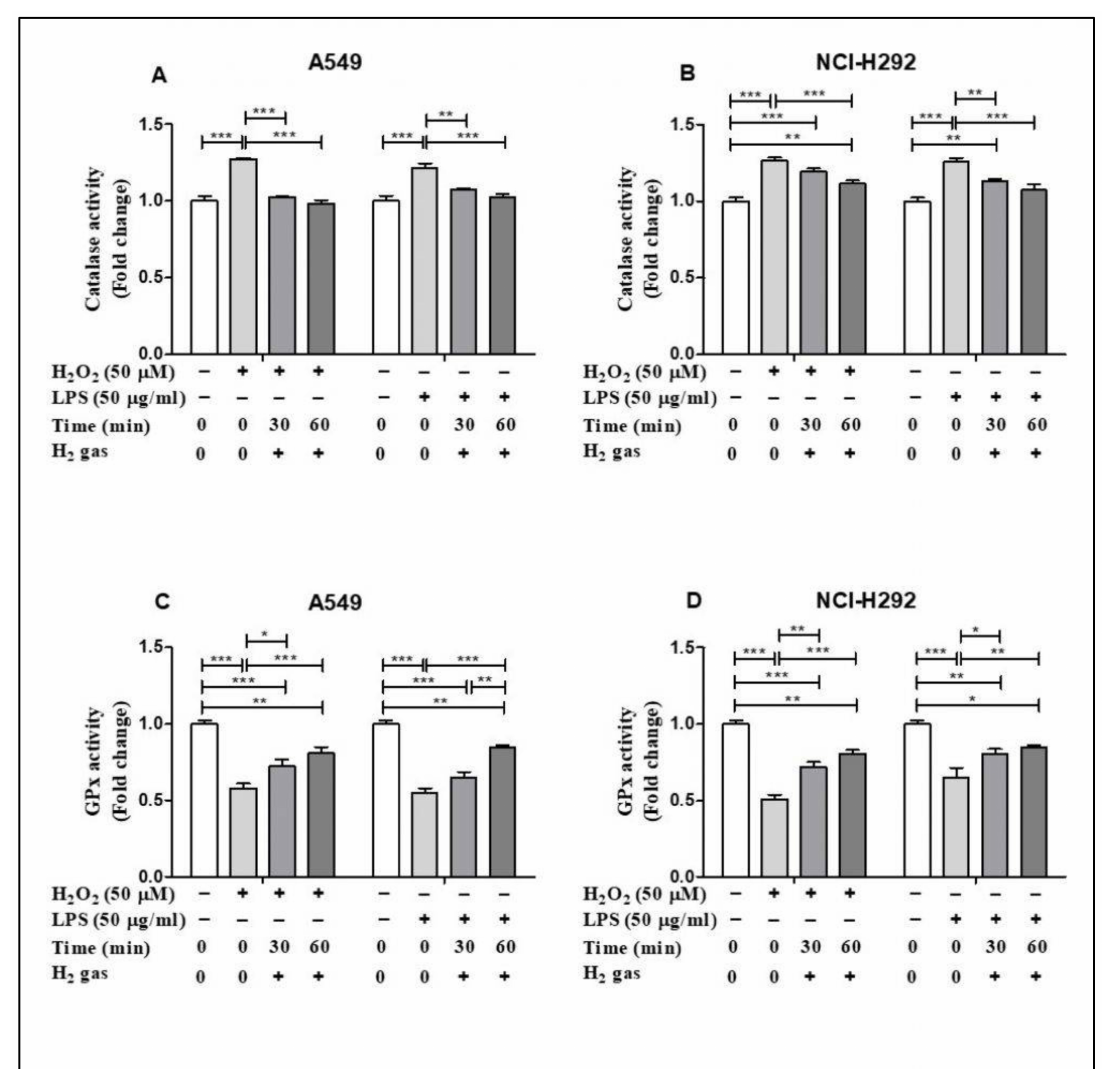
Figure 4. Influence of 2% H 2 gas on CAT and GPx activity in H 2 O 2 and LPS-induced A549 and NCI-H292 cells. H 2 O 2 and LPS were administered to cells at concentrations of 50 µ M and 50 µ g/mL, respectively. RPMI media was added and the cells incubated for 24 h after which they were washed and rinsed with 1x PBS. After 24 h of H 2 treatment, the supernatant was isolated and CAT and GPx assay were performed. ( A ) CAT activity in A549 cells. ( B ) CAT activity in NCI-H292 cells. ( C ) GPx activity in A549 cells. ( D ) GPx activity in NCI-H292 cells. Data are presented as mean ± SEM. Statistical significance was computed using ANOVA. * p < 0.05, ** p < 0.01 and *** p <